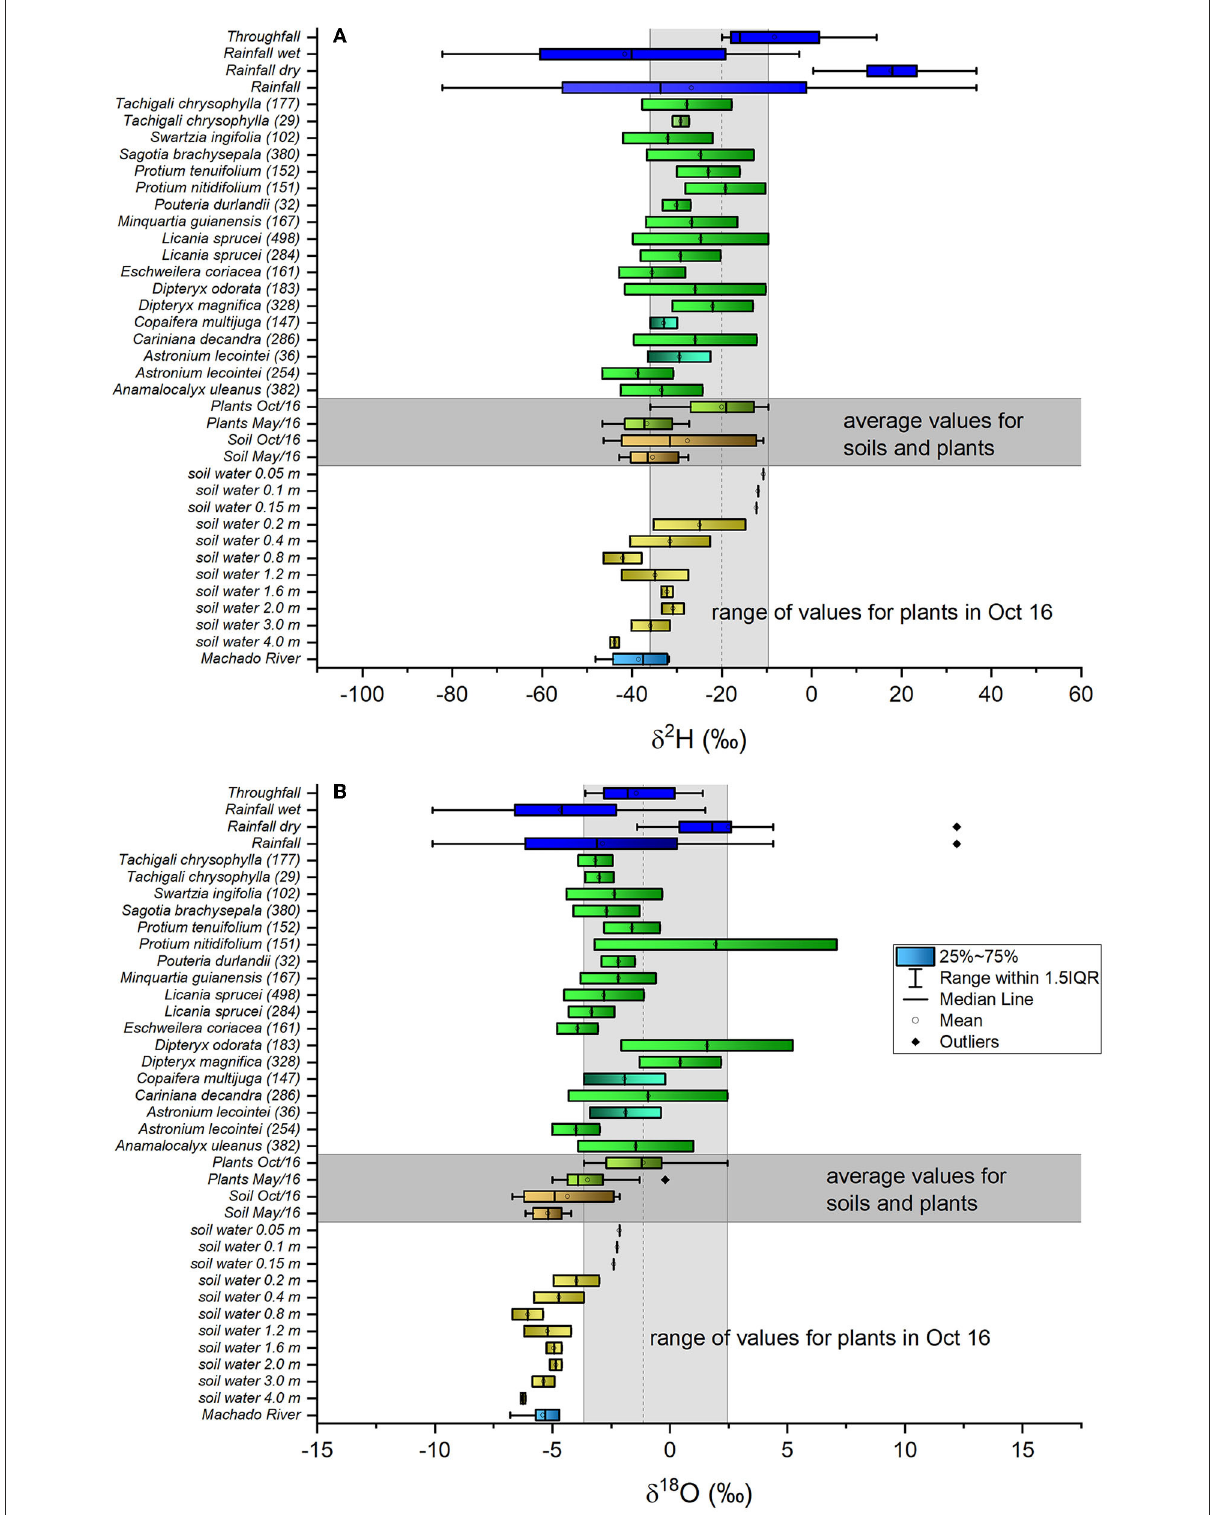
FIGURE3 Boxplot charts for δ 2 H (A) and δ 18 O (B) signals for the rainfall (all periods, wet and dry periods, and throughfall) (in bright blue), xylem water (in May 2016 and October 2016) for all sampled trees (in green), soil water at various depths (in yellow), and river water (in blue–green) samples. It is also shown the averaged values of all xylem water signals (in green), and for all soil water signals (in brown) for May 2016 and October 2016. May 2016 is considered the wet-to-dry (WTD) transition period, and October 2016 is the dry-to-wet (DTW) transition period. The boxplots show median (black line), 1st and 3rd quartiles (box), max/min observations (upper and lower lines), and the outliers (black points), when